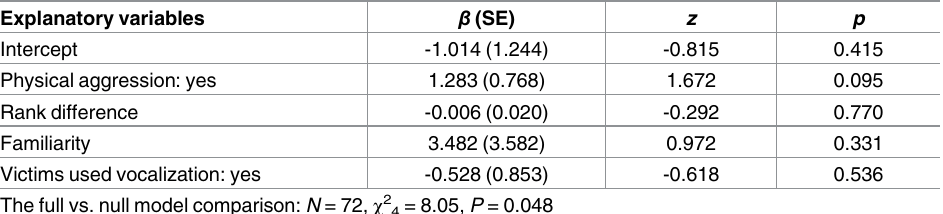
Table 4. GLMM logistic regression results for the effectof vocal use, conflict characteristics, and rela- tionship with the former opponent on the probability of receiving further aggression after post-con- flict